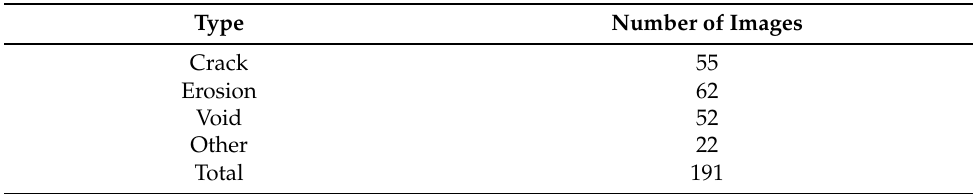
Table 2. Number of images per defect type in the original dataset. The original dataset is the baseline